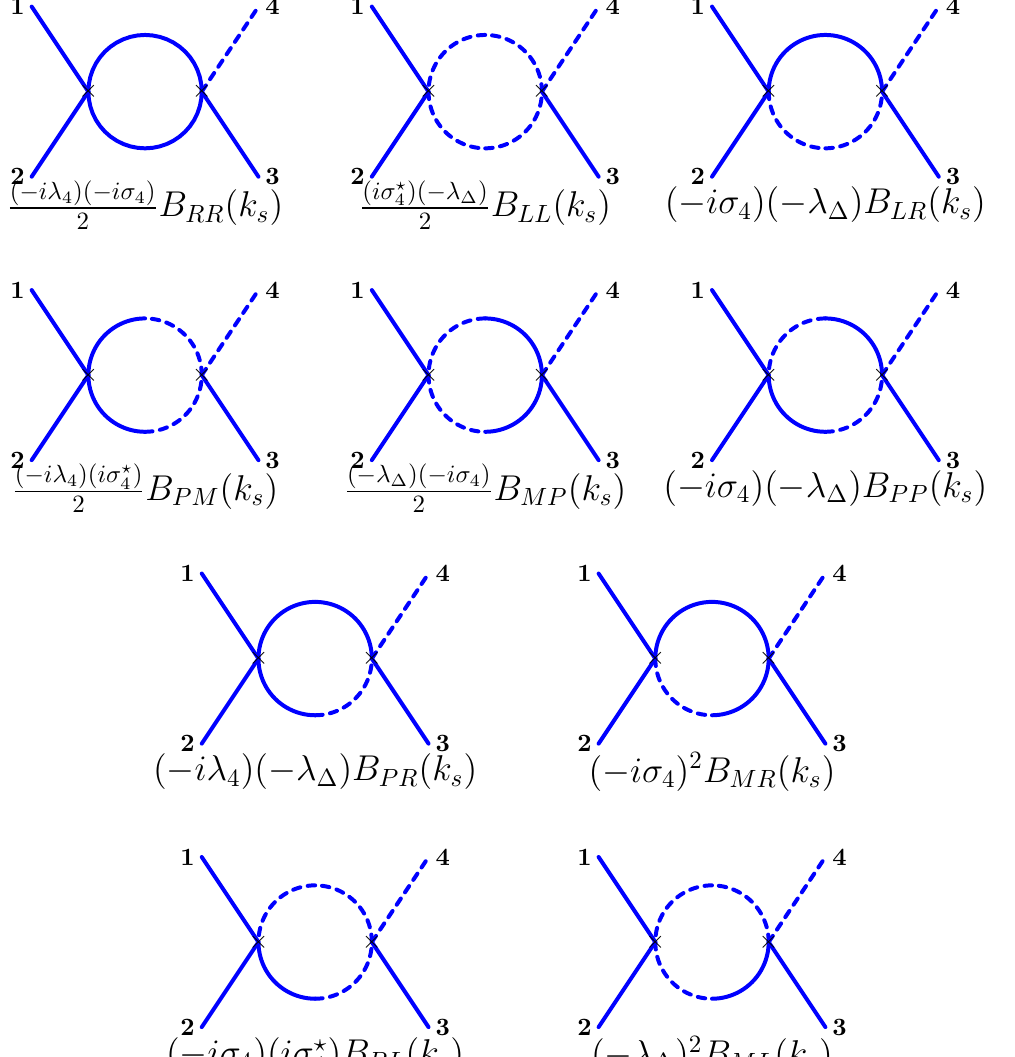
Figure 14. Diagrammatic representation of the Ten 1-Loop Integrals (cid:30) R (cid:30) R